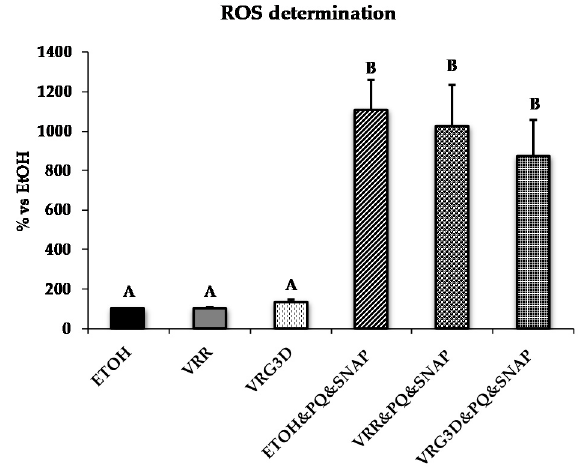
Figure 3. Effects of treatment with different mung bean extracts on Reactive Oxygen Species (ROS) production by U937 cells challenged with peroxynitrite. Results are represented as means ± SEM. Superscripts when different indicate p < 0.05. ETOH, ethanol. VRR, raw Vigna radiata . VRG3D, 3d-germinated Vigna radiata . ETOH&PQ&SNAP, ethanol plus PQ / SNAP. VRR&PQ&SNAP, raw Vigna radiata plus PQ / SNAP. VRG3D&PQ&SNAP, 3d-germinated Vigna radiata plus PQ / SNAP. PQ, Paraquat . SNAP, S-nitroso-N-acetylpenicillamine .